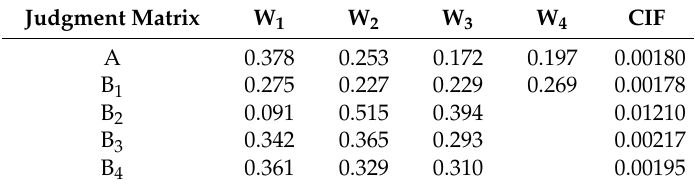
Table 3. Calculation results of the judgment matrix based on the PSO-AHP model.